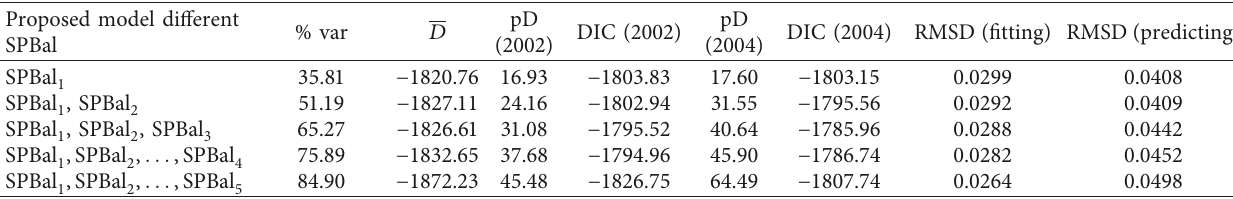
Table 2: Female dataset at family taxonomic level. Results obtained when estimating the proposed model using different selected principal balances. Additionally, the table shows the deviance information criterion (DIC) defined in [63], the DIC defined in [64], the root mean square deviation (RMSD) of the results obtained fitting the model, and the RMSD of the results obtained using the model for prediction.